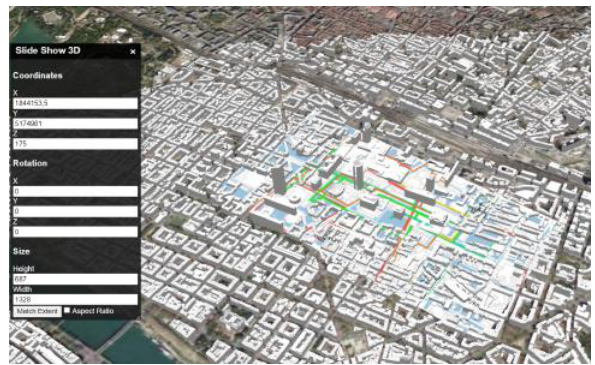
Figure 5. An example of the slideshow. The configuration window (on the left) allows to set its parameters. One image of the slideshow is shown on a ground plane in the 3D